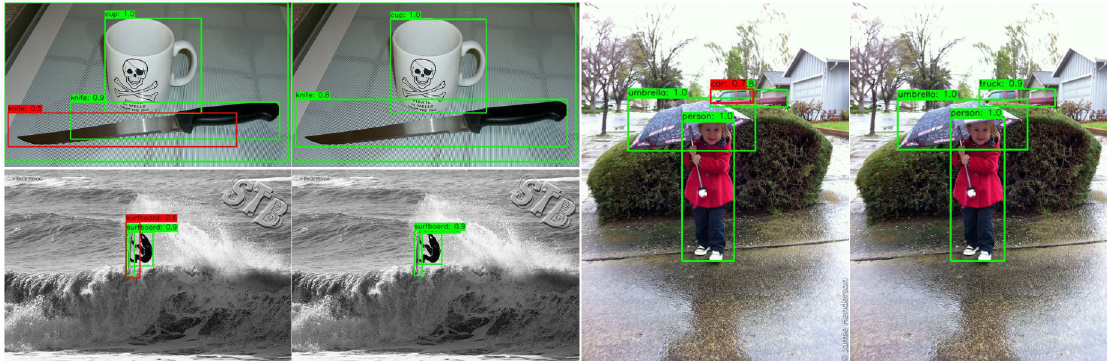
Fig 4. Detection results of Faster RCNN (left in each couple) and Faster RCNN þ L 2 correct detection results; red boxes: incorrect detection results. Each box is marked with its estimated class name and confidence score.